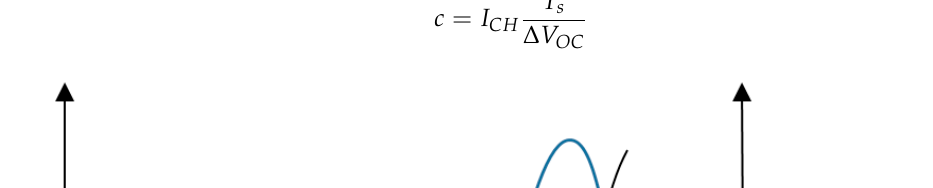
Figure 8. Constant current charging ( a ) SOC to voltage and ( b ) charging function.